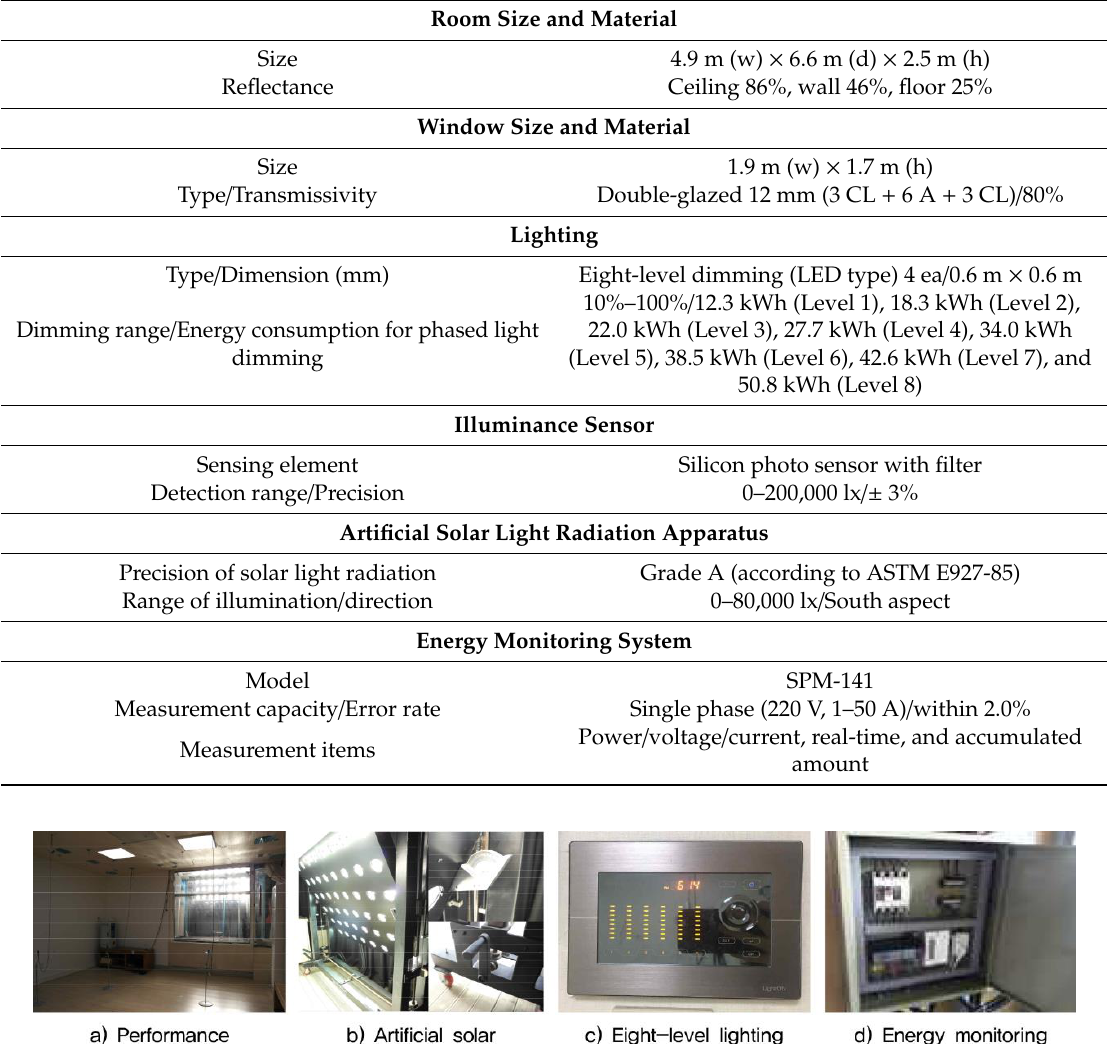
Table 4. Details of test bed and chamber.